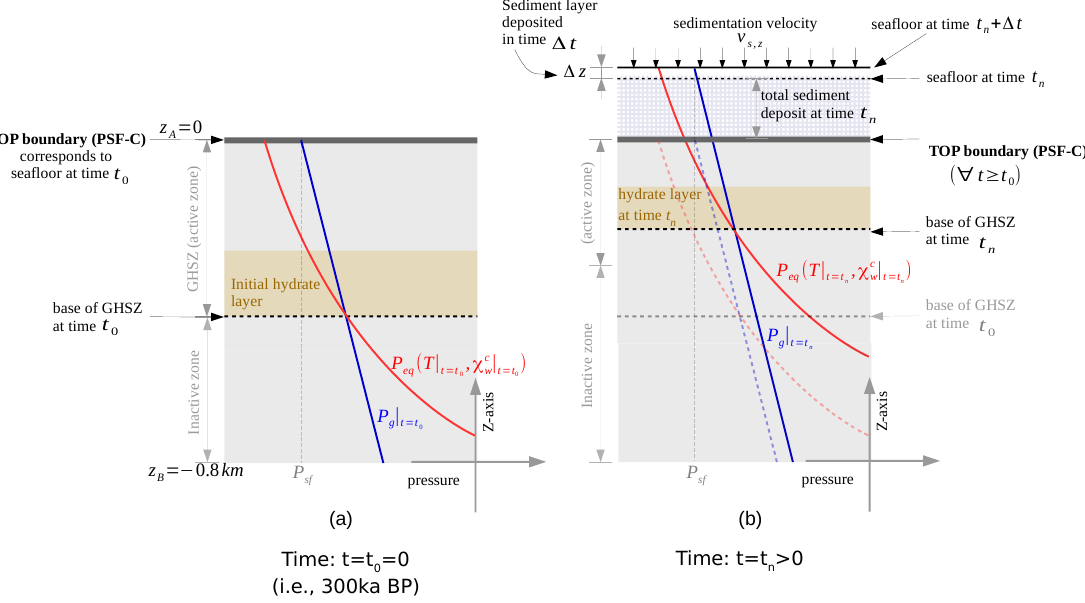
Figure 3. Problem setting for Example 1 (Section 4.1). ( a ) The initial state of the system and identifies the corresponding gas hydrate stability zone (GHSZ). ( b ) The state of the system at t = t n > 0, illustrating how the GHSZ shifts as a result of sedimentation over